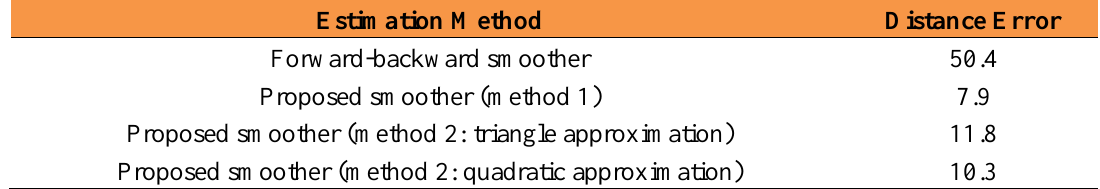
Table 3. The start-stop point distance error of curve movement experiment (in mm).